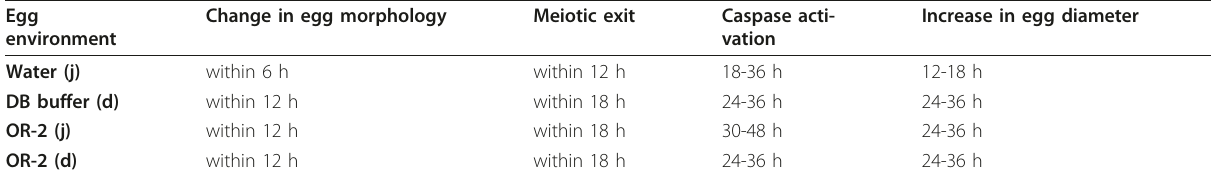
Table 1 Timing of morphological and biochemical changes in the unfertilized Xenopus eggs deposited into different buffers.